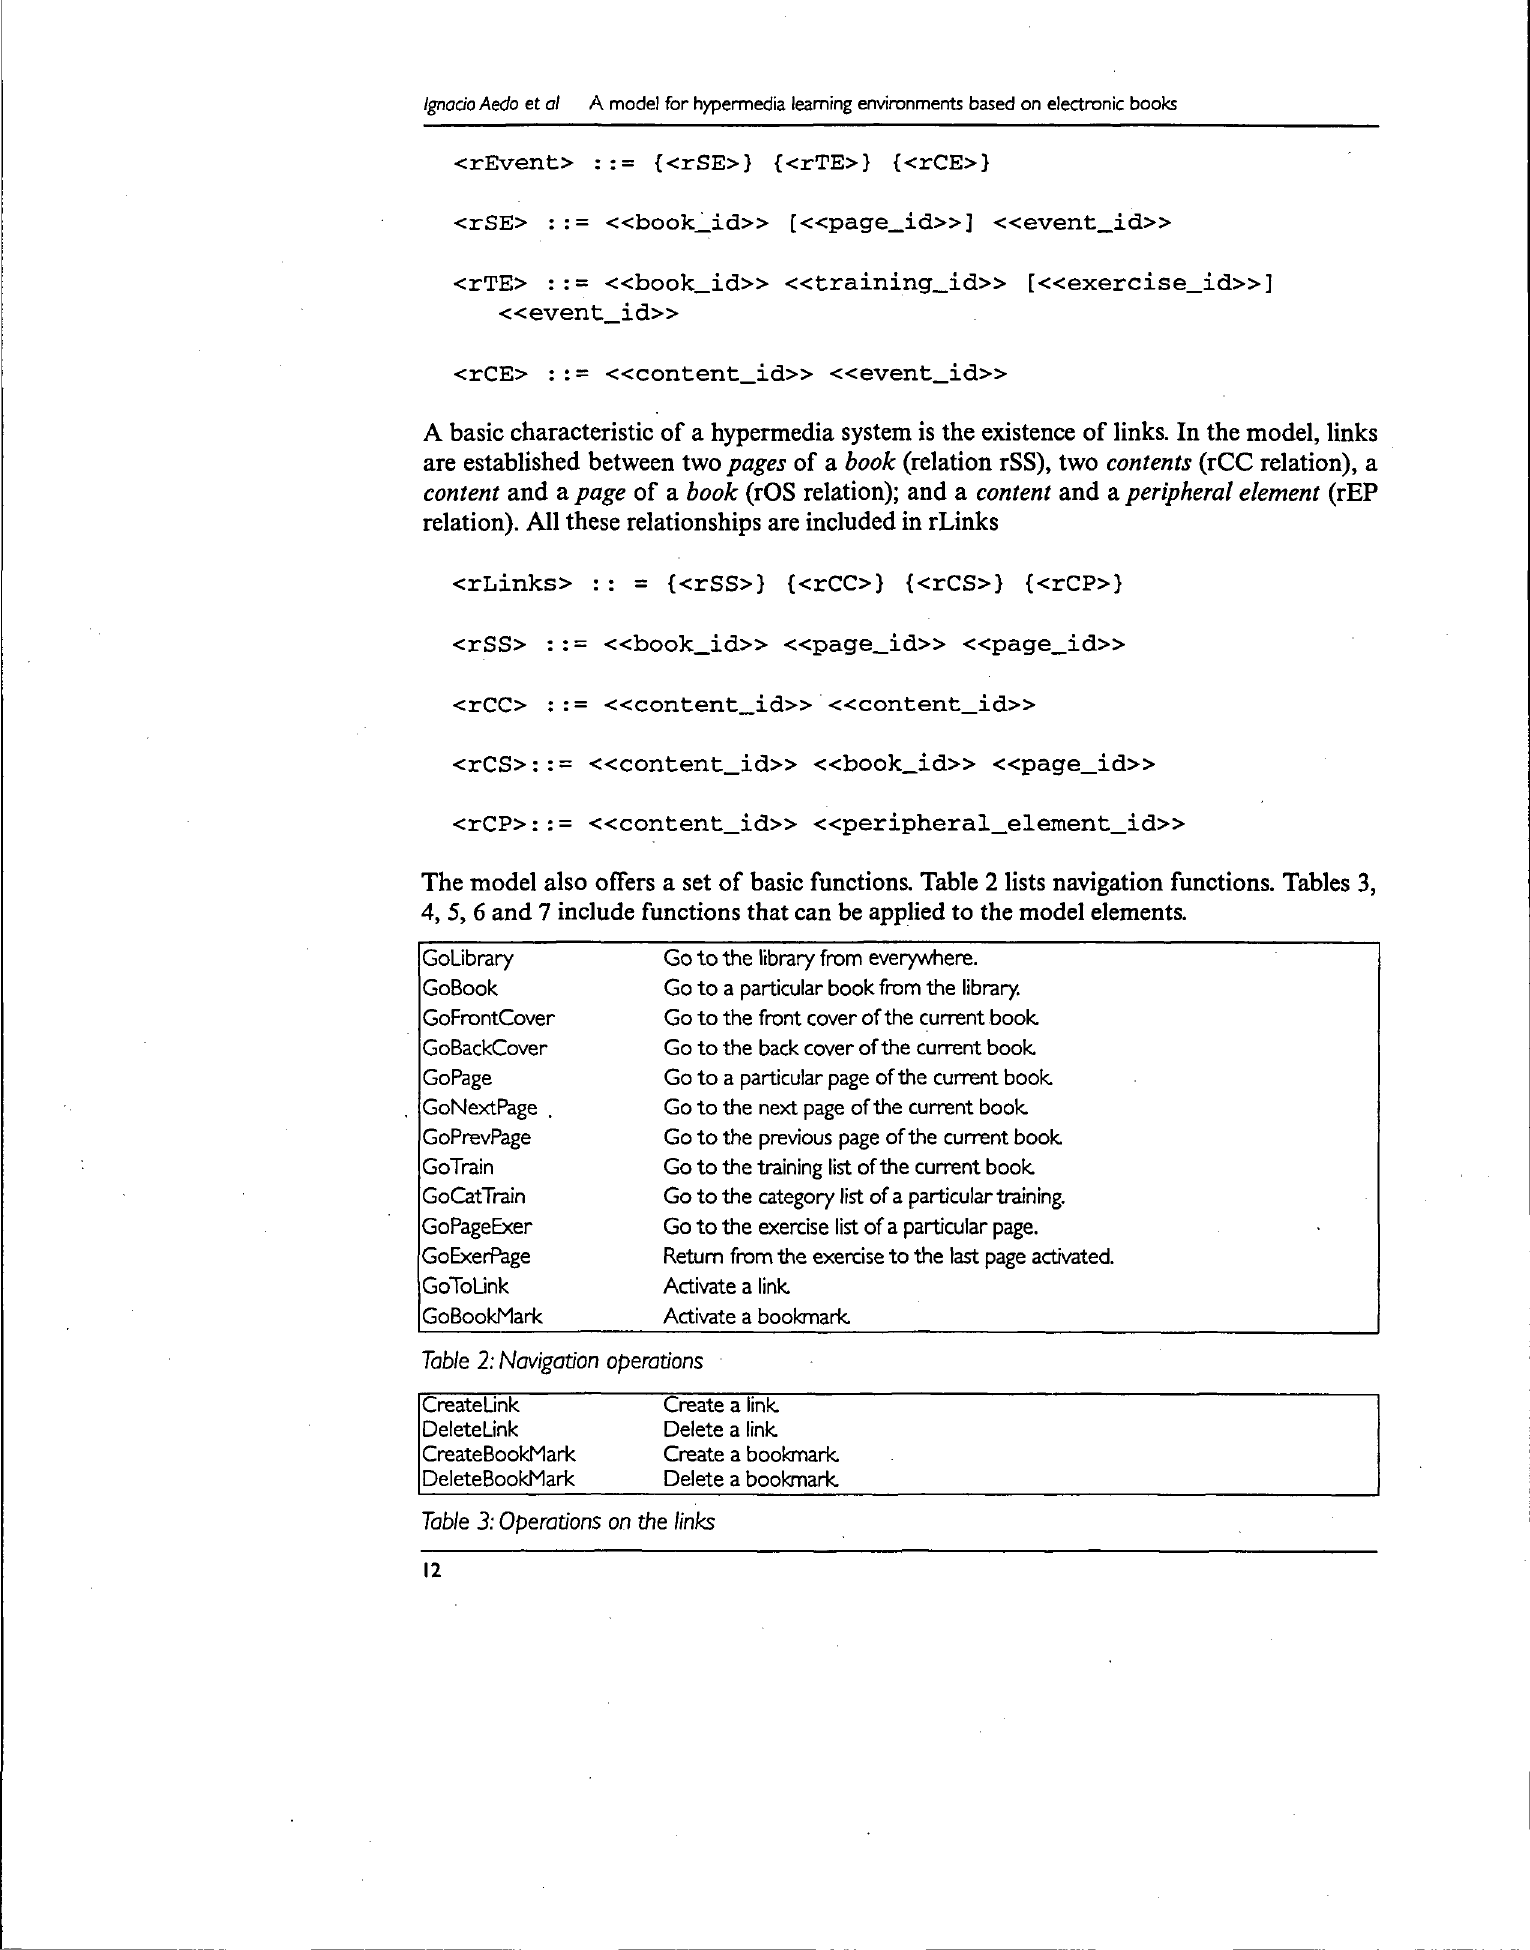
Table 2: Navigation operations Create Link DeleteLink